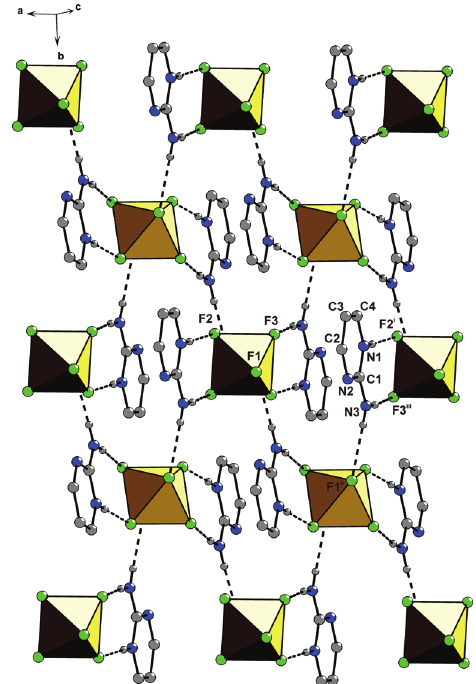
Figure 1. 2D layered structure and atom numbering scheme of 1 . The hydrogen atoms on aromatic rings have been removed for cla- rity. Symmetry codes: (i) x –1, y , z ; (ii) x –1/2, – y +3/2, z ; (iii) – x , – y +1, – z .